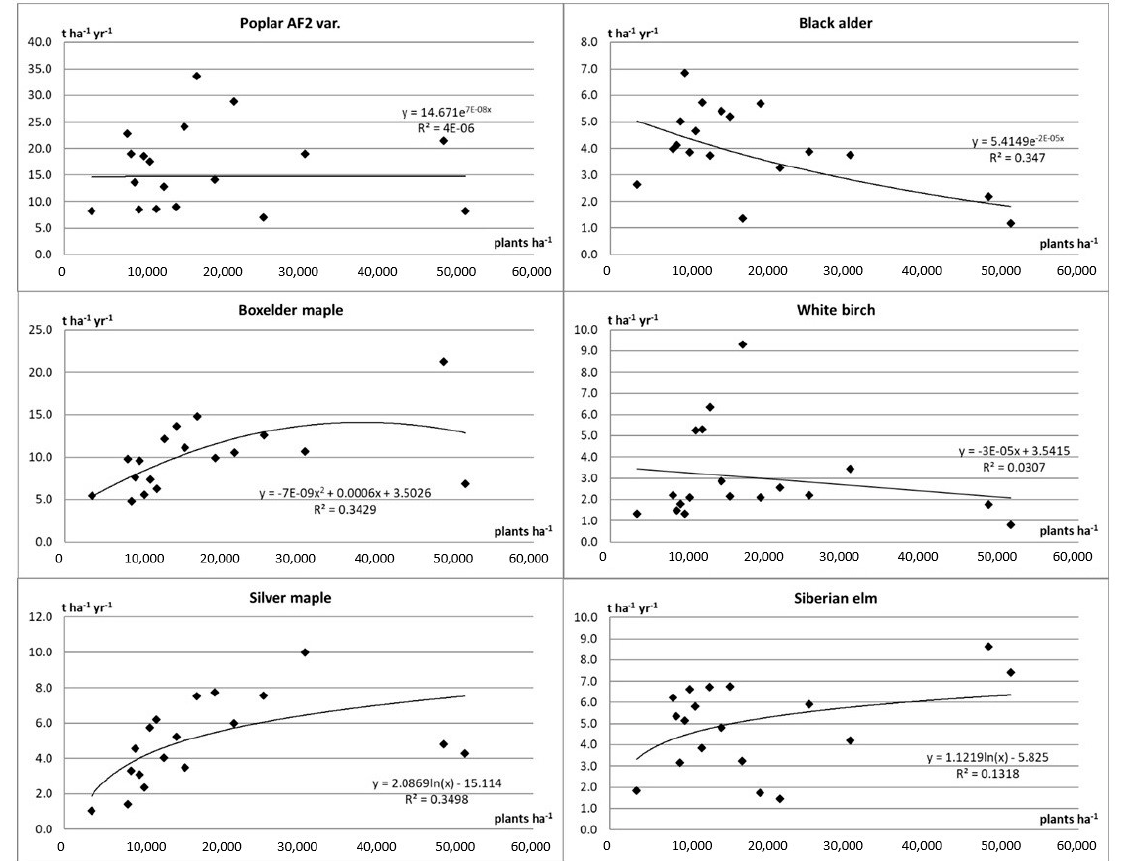
Figure 5. Relationship between potential yield of dry mass per year (t ha − 1 r − 1 ) and planting density (plants ha − 1 ).